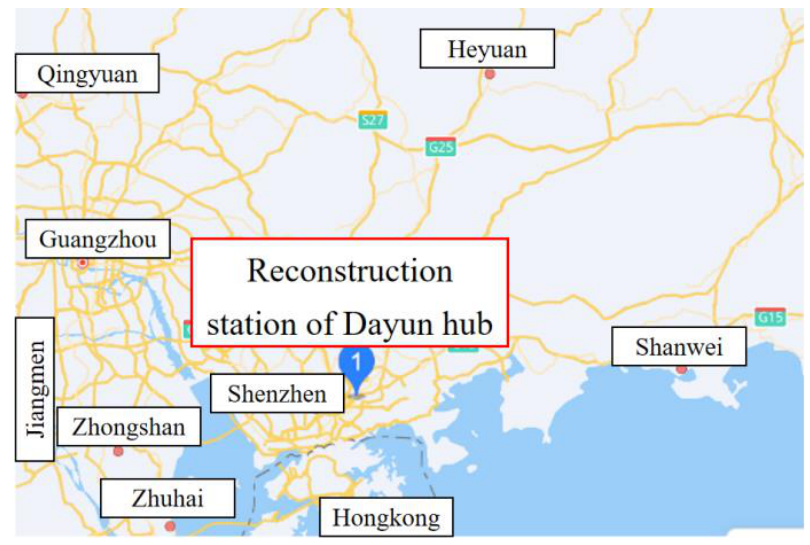
Figure 1. Location of the project in the GBA.